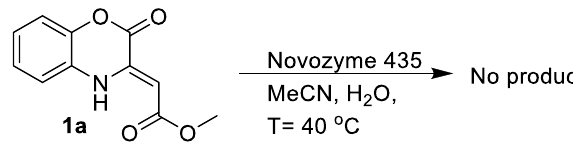
Figure 3. Control experiment for decarboxylative Michael reactions.